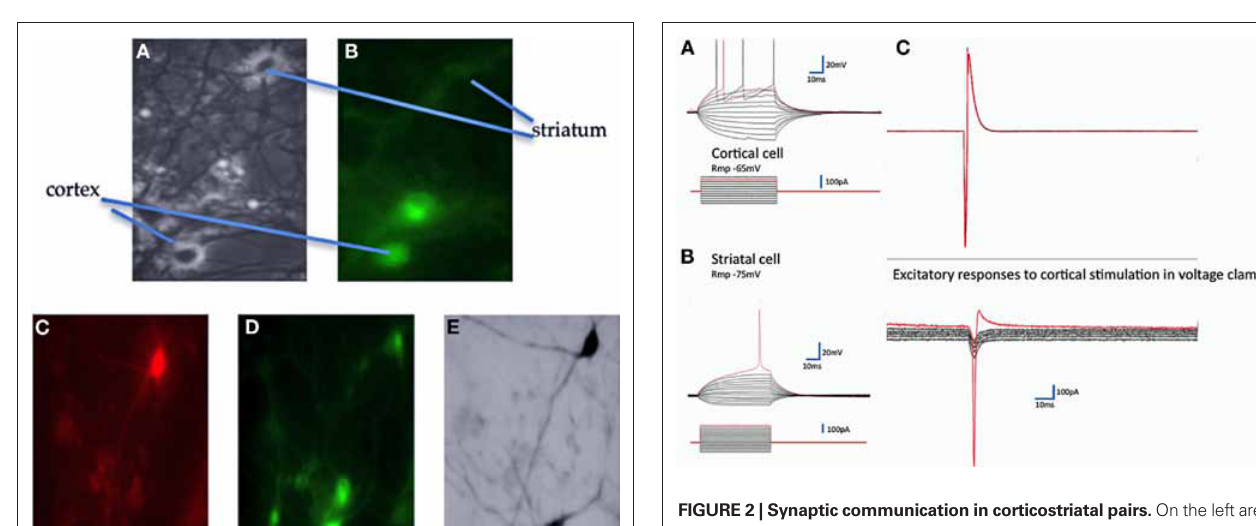
Figure 2 | Synaptic communication in corticostriatal pairs. On the left are typical records from identified cortical (A) and striatal neurons (B) recorded in current clamp. Regular current steps drive typical voltage changes in these two classes of neurons (Rmp, resting membrane potential). The red traces are at threshold for action potential generation. To the right, in (C) records from a pair of neurons – the excitatory currents evoked in a striatal neuron by the firing of the cortical neuron. The synaptic currents are the average of five repeats of the stimulation with the receiving neuron clamped at each of six different resting potentials − 80 to − 30 mV (10 mV steps). The response to the stimulation in this striatal neuron is close to the mean response in all 32 cases ( − 100 pA at − 80 mV). The red traces again show the threshold for activation of an action current in the striatal neuron. The (unclamped) action current in the cortical neuron illustrated above in response to 150 mV intracellular depolarizing pulse 2 ms long allows estimation of the latency of the response – here